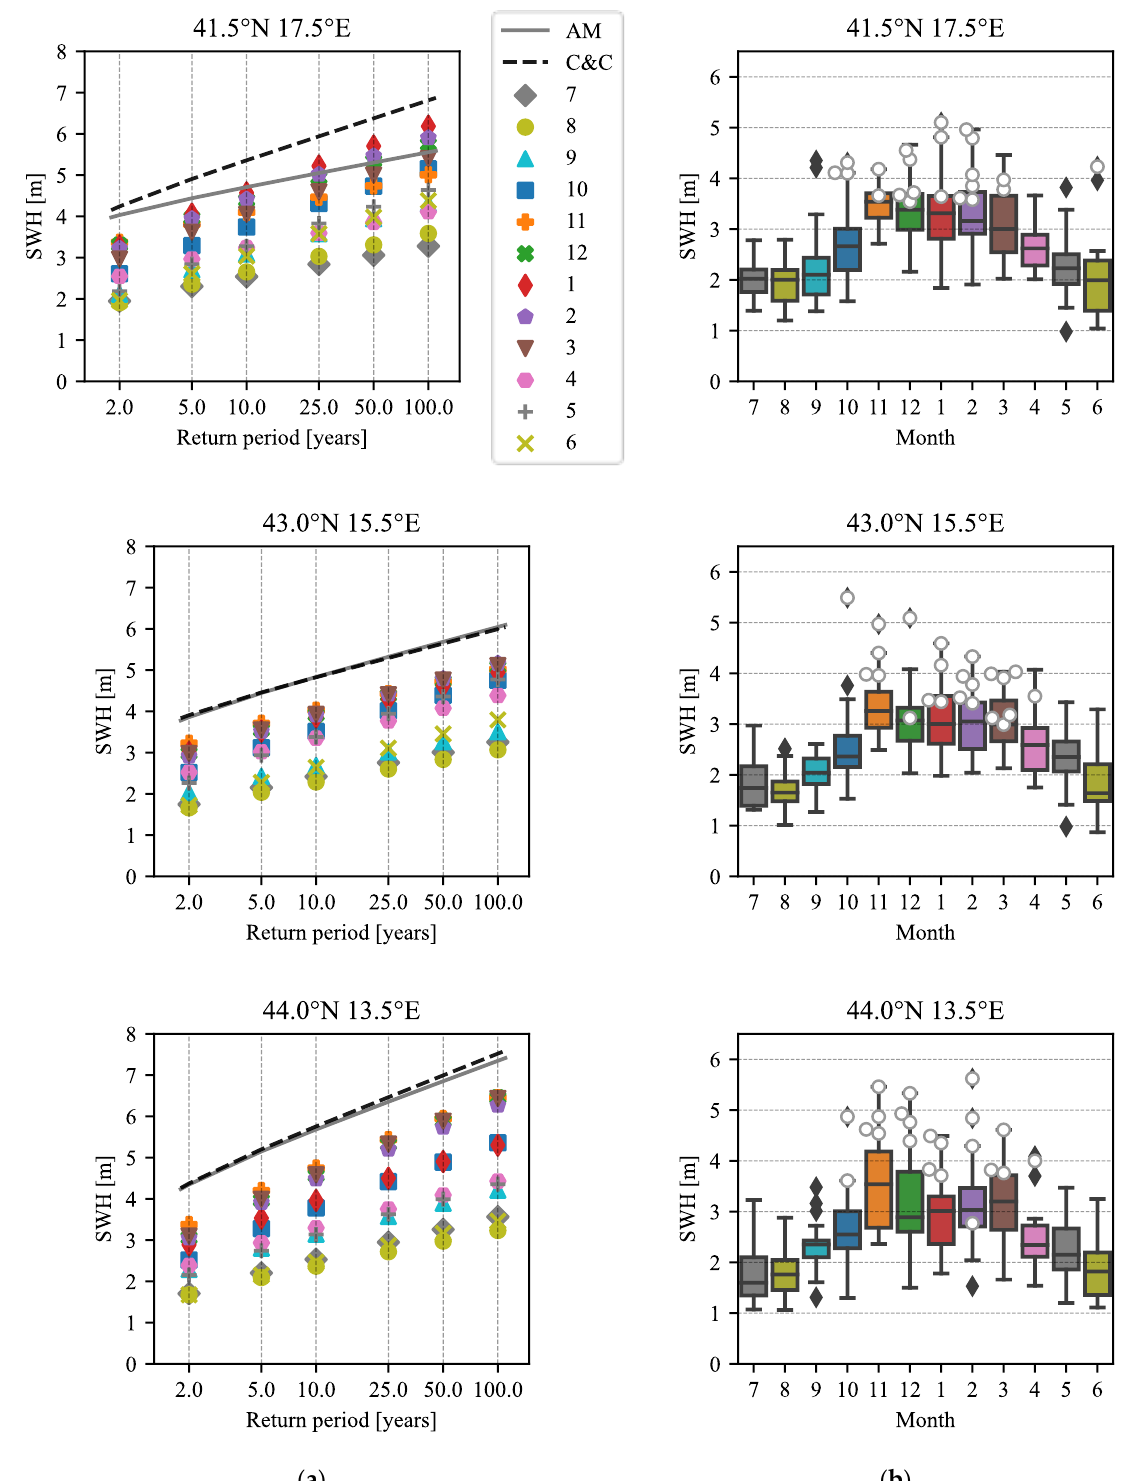
Figure 7. Seasonality (Within-year climate variability) effect for three characteristic locations: ( a ) The extreme SWHs calculated based on different return periods. Markers represent results from individual months, while the dashed gray line displays values obtained by the C–C approach combining MM; ( b ) Box plot describing the dispersion of maxima that occurred in a given month. White circles highlight the values that are also the annual maxima that occurred in a given month.